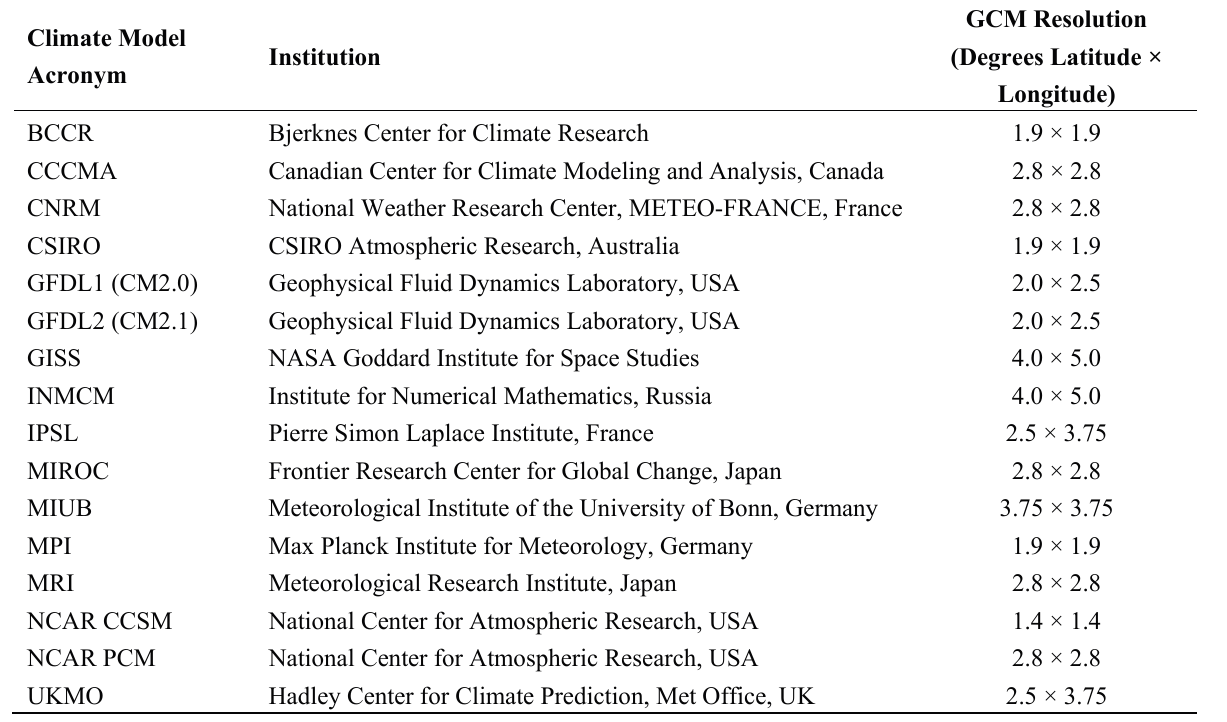
Table 1. Global-scale climate models for which downscaled data were used in the present study. Climate